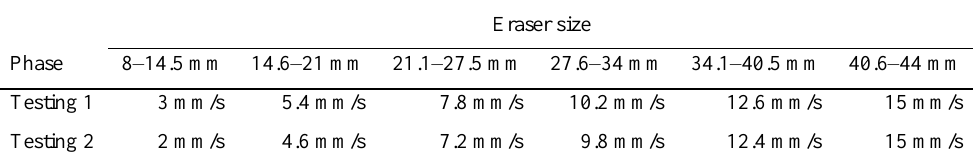
Note : Eraser sizes represent the height or width (not the area) of the eraser. Eraser speeds in the